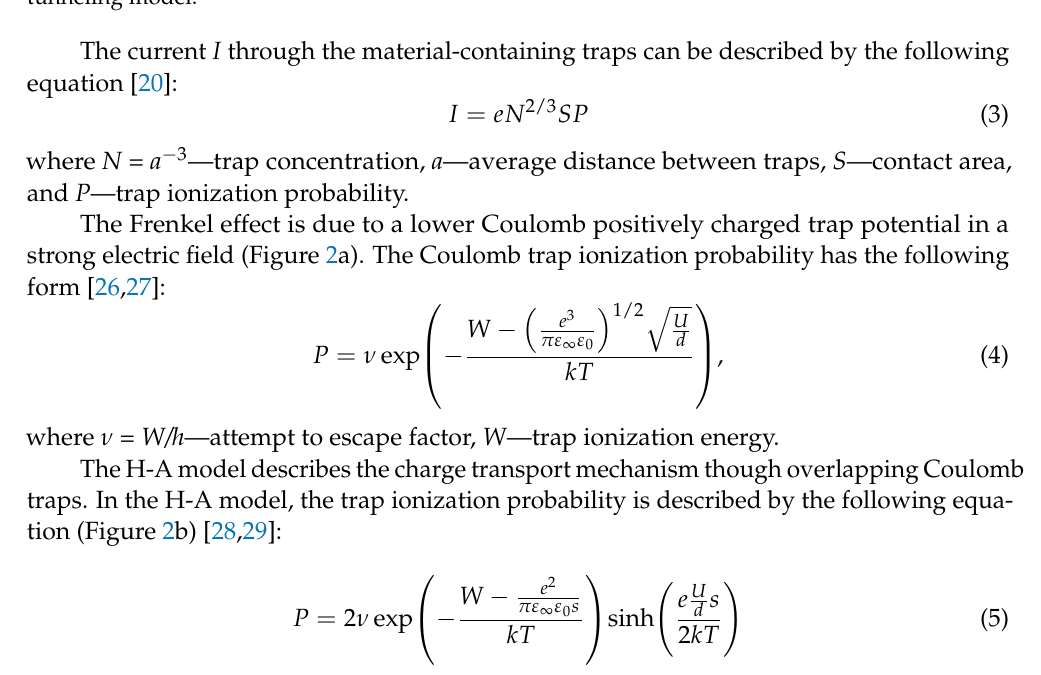
Figure 1. Schematic diagram of contact-limited models: ( a ) Schottky effect, ( b ) thermally assisted tunneling model.